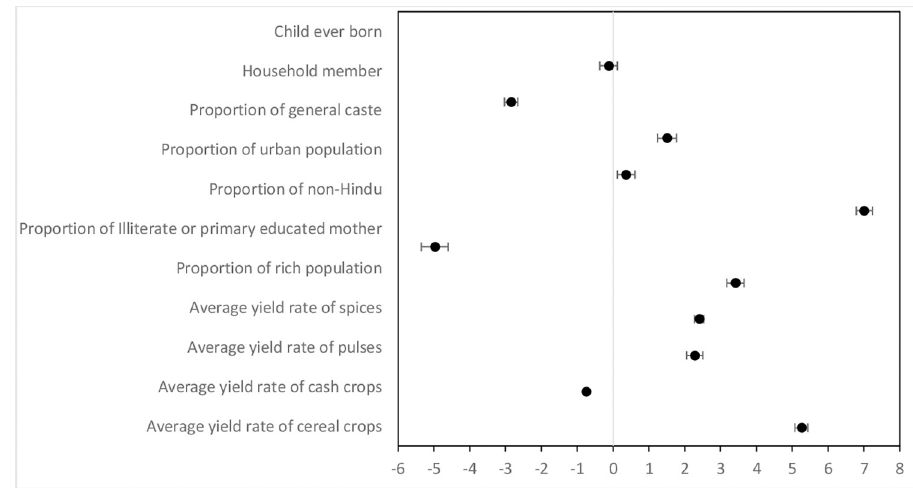
Fig 3. Forest plot showing relation between crop yield rate and MAD in India,